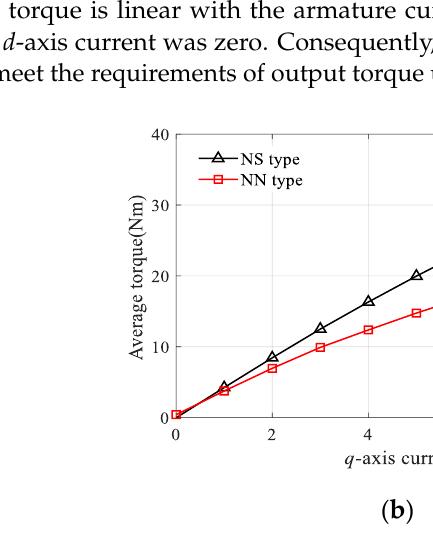
Figure 17. Comparison of electromagnetic torques of AF-FMPM machine topologies. ( a ) Torque at rated speed and rated current; ( b ) average torque versus currents.